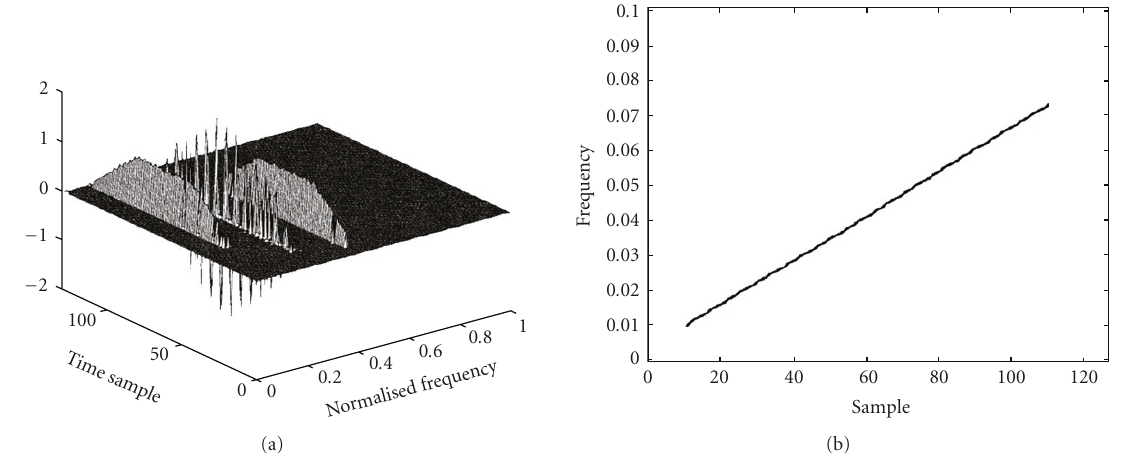
Figure 11: (a) High-resolution TFD for x ( n ) using the raw LAF values (PWD equivalent). (b) High-resolution result for a complex exponential signal over 128 time samples (adopted from Amin and Williams